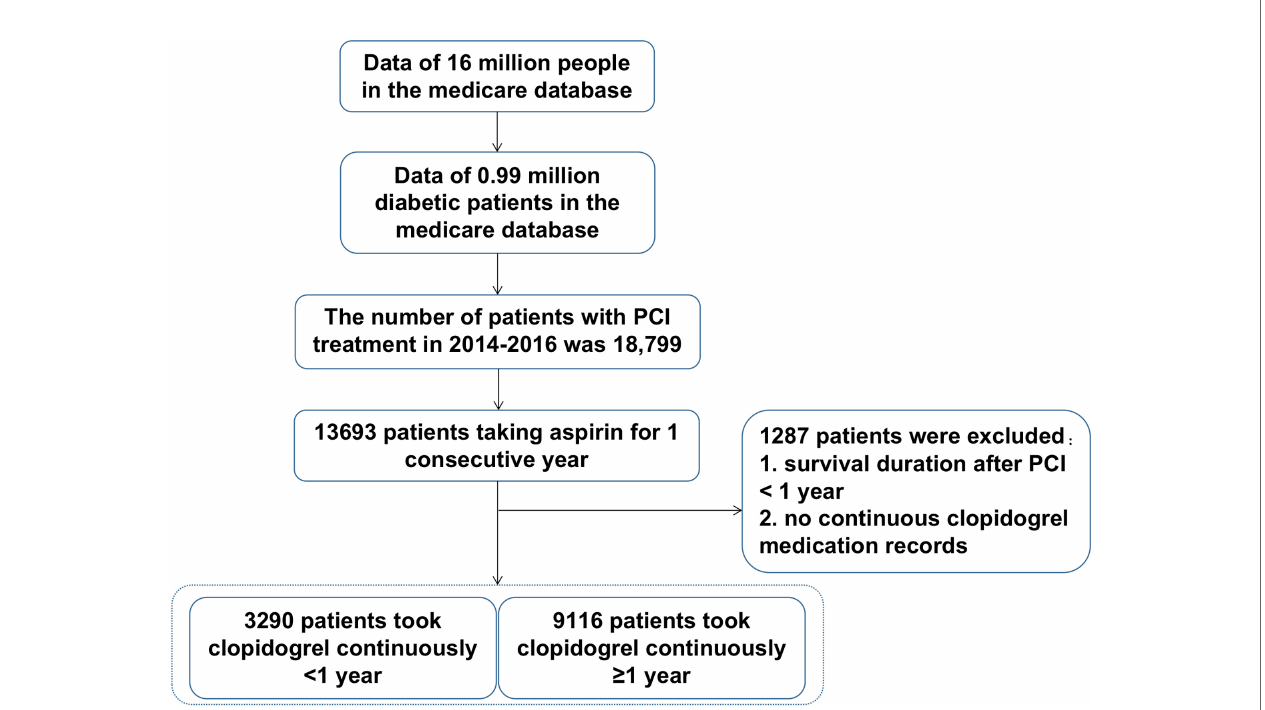
FIGURE 1 | The selection process of included